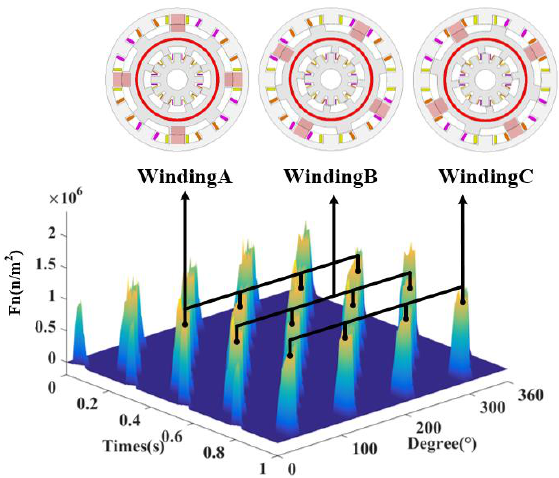
Figure 13. Radial electromagnetic force – rotor position – time waveform of DDSRG.